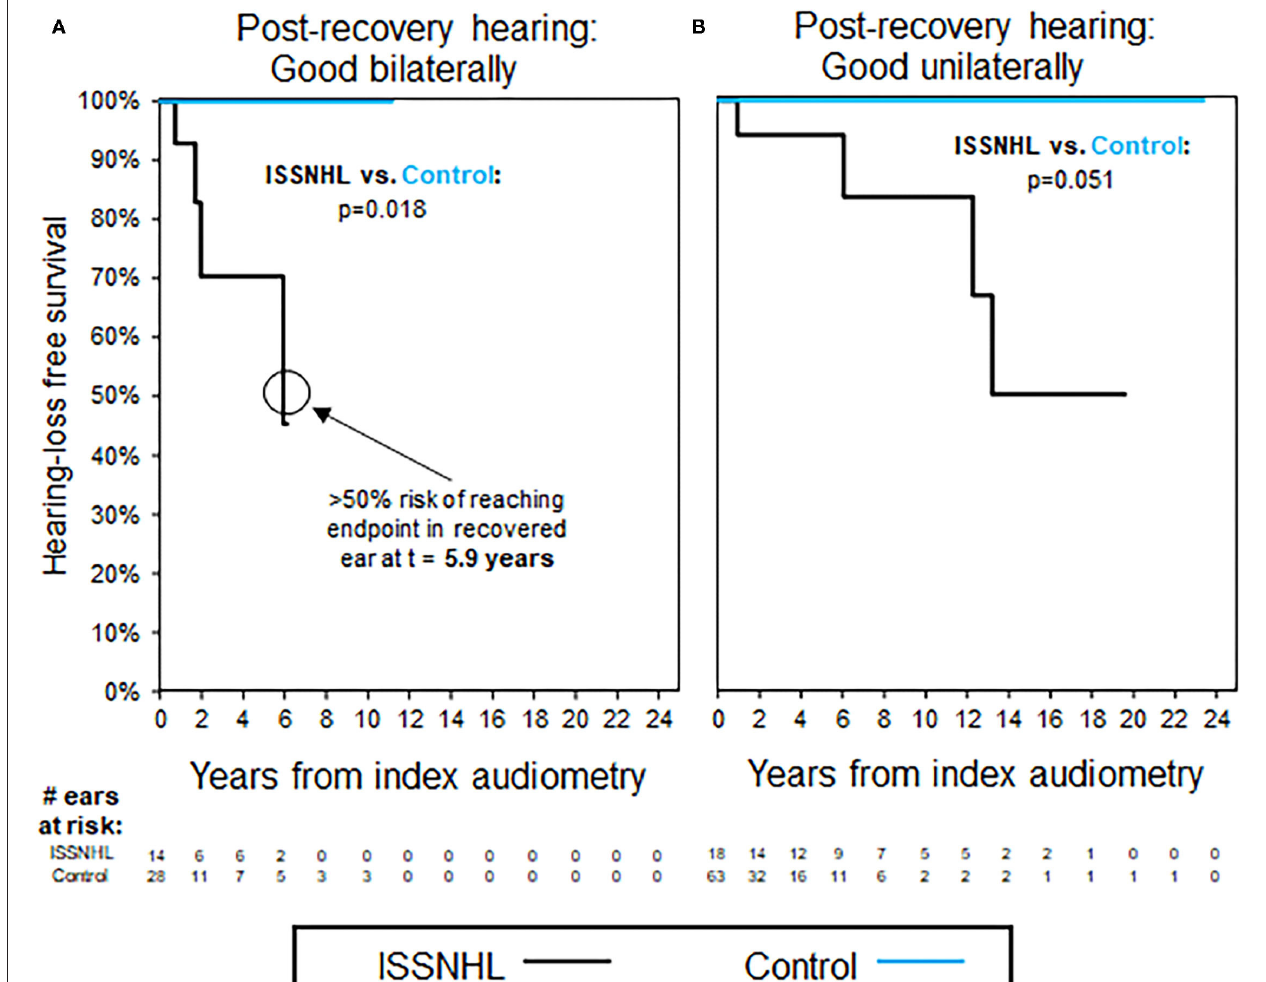
FIGURE 3 | Kaplan–Meier curves for hearing loss progression in the patients with bilateral ISSNHL and recovery to good hearing in at least one ear; as shown in Table 3 for demographics. (A) The patients with good hearing bilaterally, endpoint non-serviceable hearing. (B) The patients with good hearing in one ear only, endpoint non-serviceable hearing. All the control ears with good